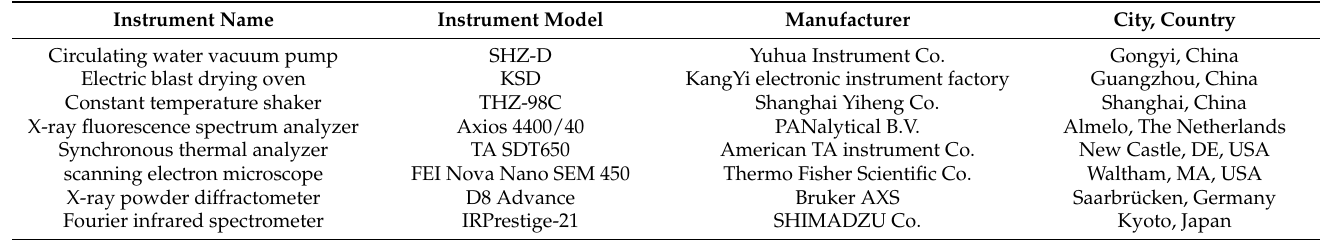
Figure 12. The images of molybdenum oxide and molybdenum disulfide.